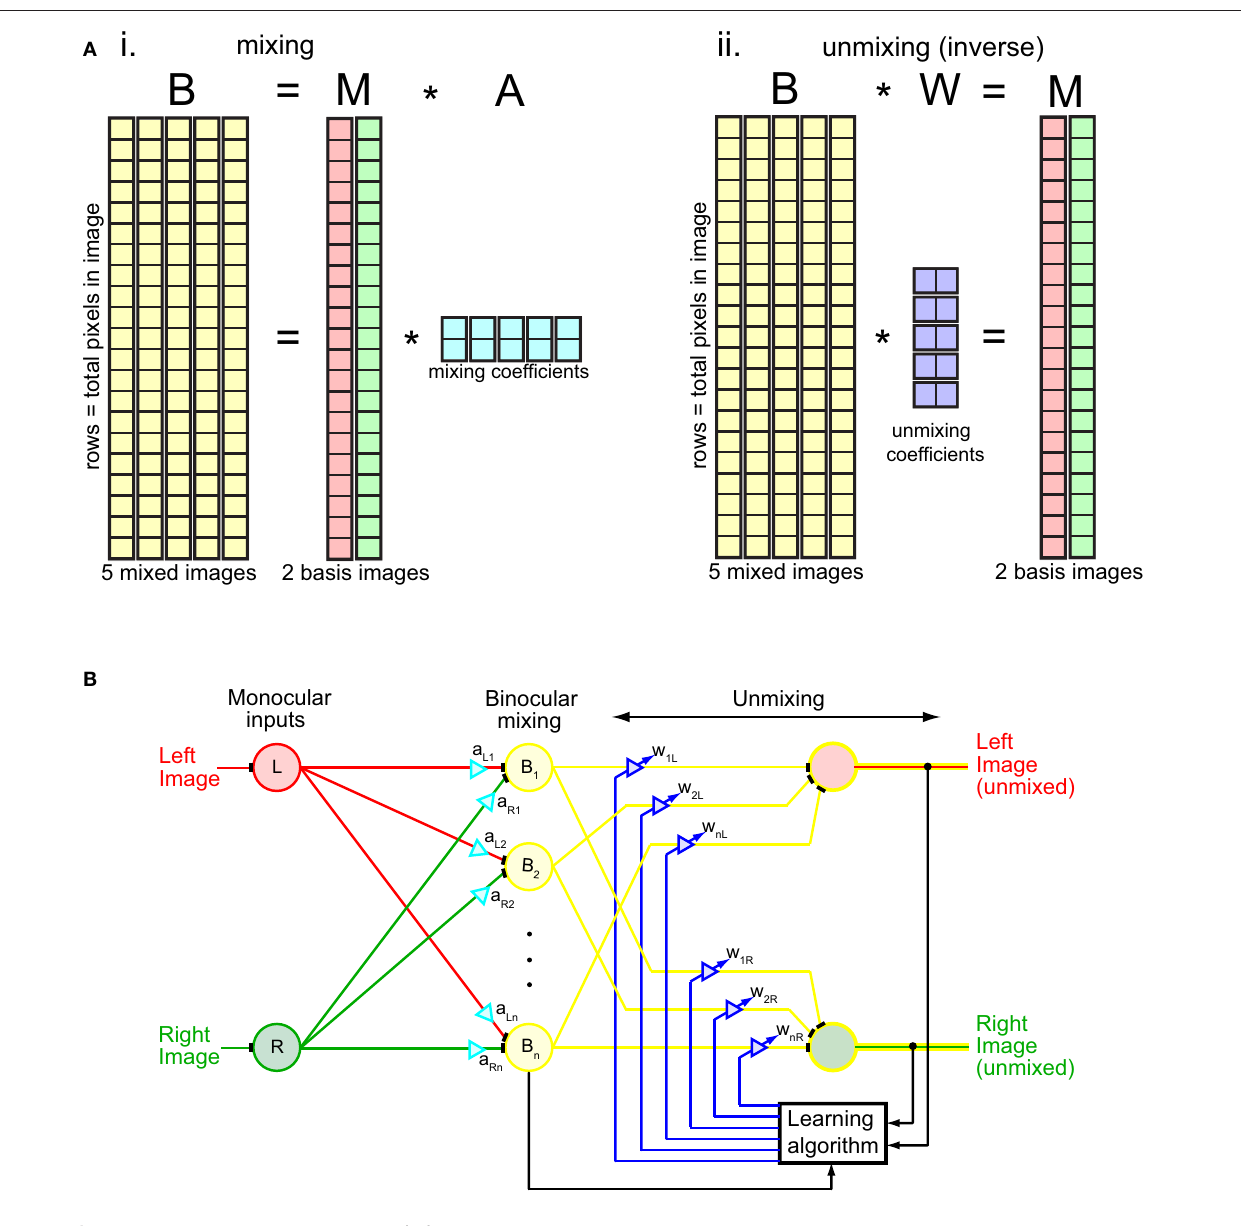
Figure 2 | Mechanics of the unmixing algorithm. (Ai) Matrix representation of binocular mixing. The binocular mixture matrix B had five columns, representing the five mixed images depicted in Figure 1. Each column had 40,000 rows, corresponding to 40,000 pixels in each image (200 × 200 pixels). Thus each image is “unfolded” from a 2D array to a 1D column of pixels. The binocular matrix B was factored into two non-negative matrices M and A such that B = M × A . The factorization was done by iteratively updating M and A in accord with the NMF algorithm so as to gradually reduce error between B and M × A , with error based on entropy